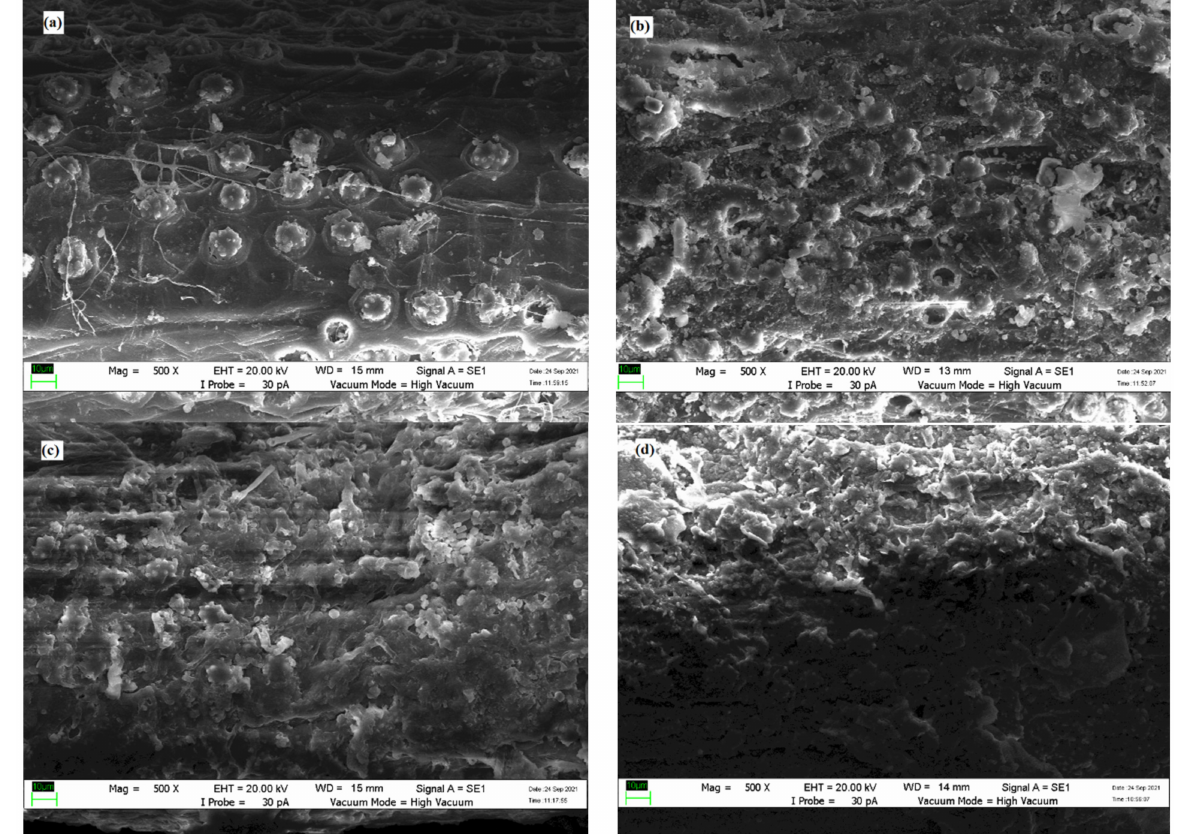
Figure 4. SEM images of samples ( a ) untreated, ( b ) treated with 170 ◦ C at 20 min, ( c ) untreated wetted with oil, and ( d ) treated with 170 ◦ C at 20 min wetted with oil at different magnification (500 ×